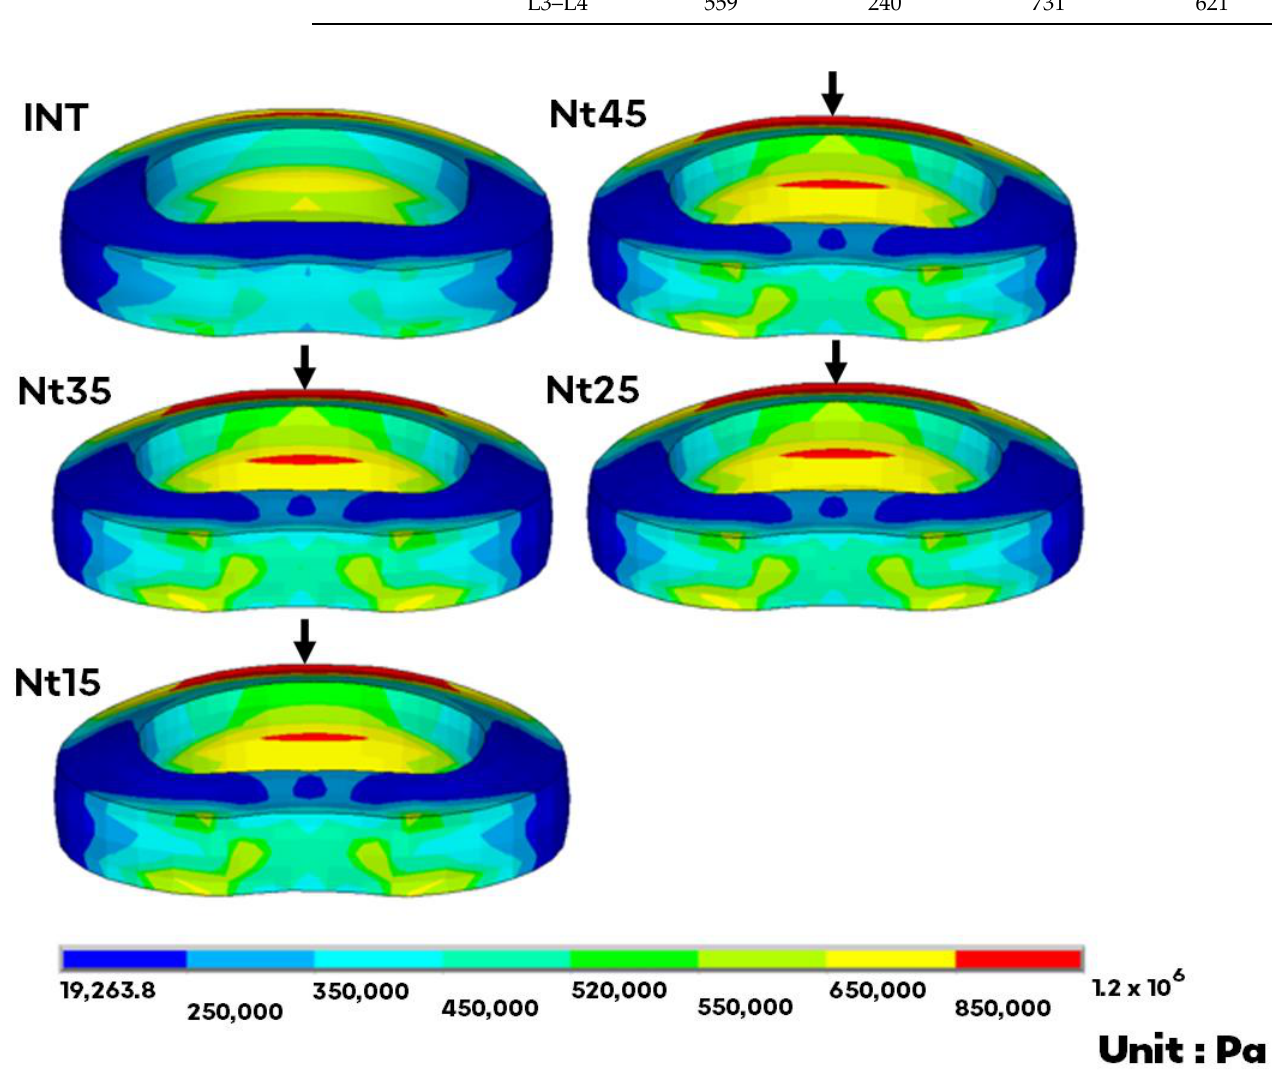
Figure 3. The von Mises stress distribution of the adjacent L2–L3 disc in flexion. The arrow indicates the maximum at the anterior superior edge. There was no obvious trend in disc stress at the adjacent level as the NS diameter changed. Table 5. Comparison of stress of intervertebral disc (KPa) in finite element models. The von Mises stress on the intervertebral disc. The NS diameter was inversely proportional to the disc stress at the implanted L3 – L4 level; it did not markedly influence the disc stress at the adjacent L2 – L3 level. Model Level